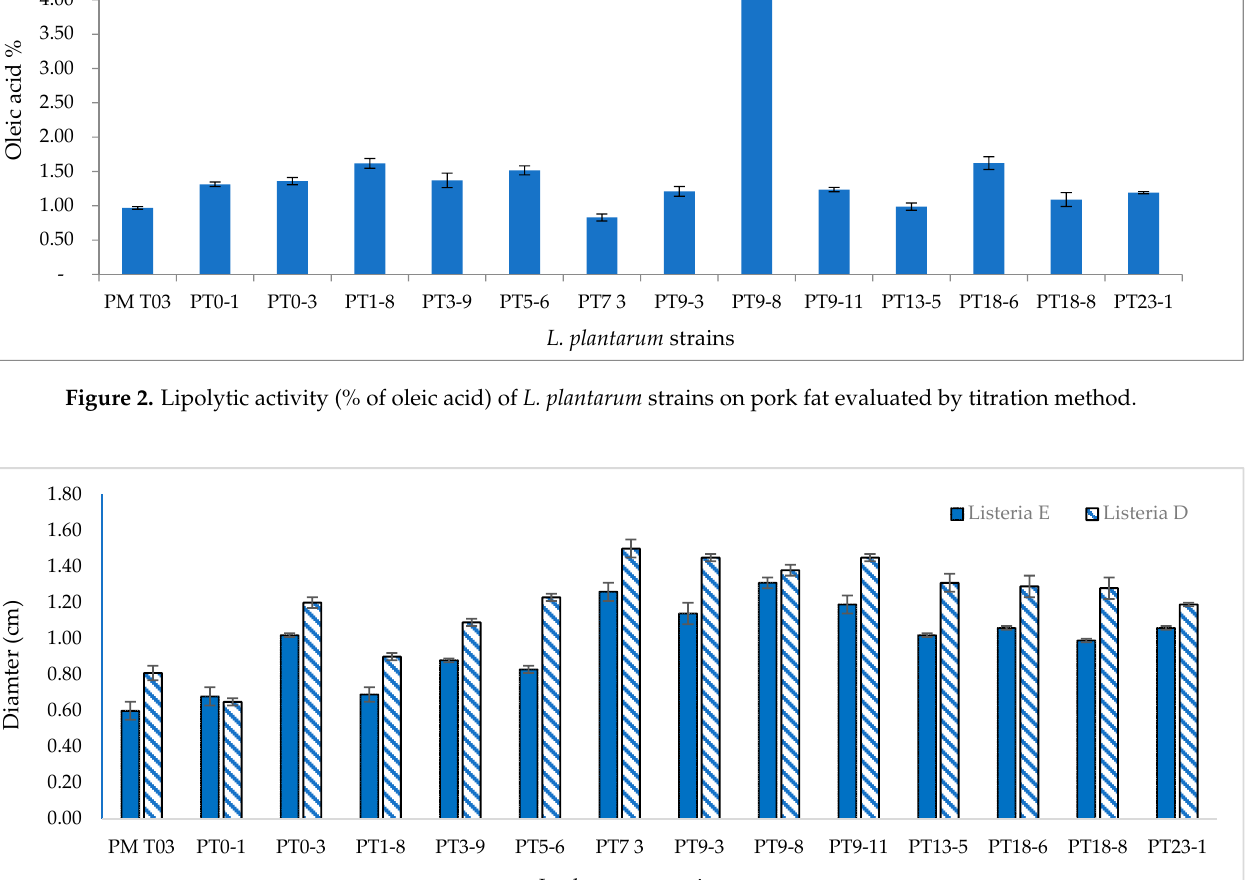
Microorganisms 2021 , 9 , x FOR PEER REVIEW